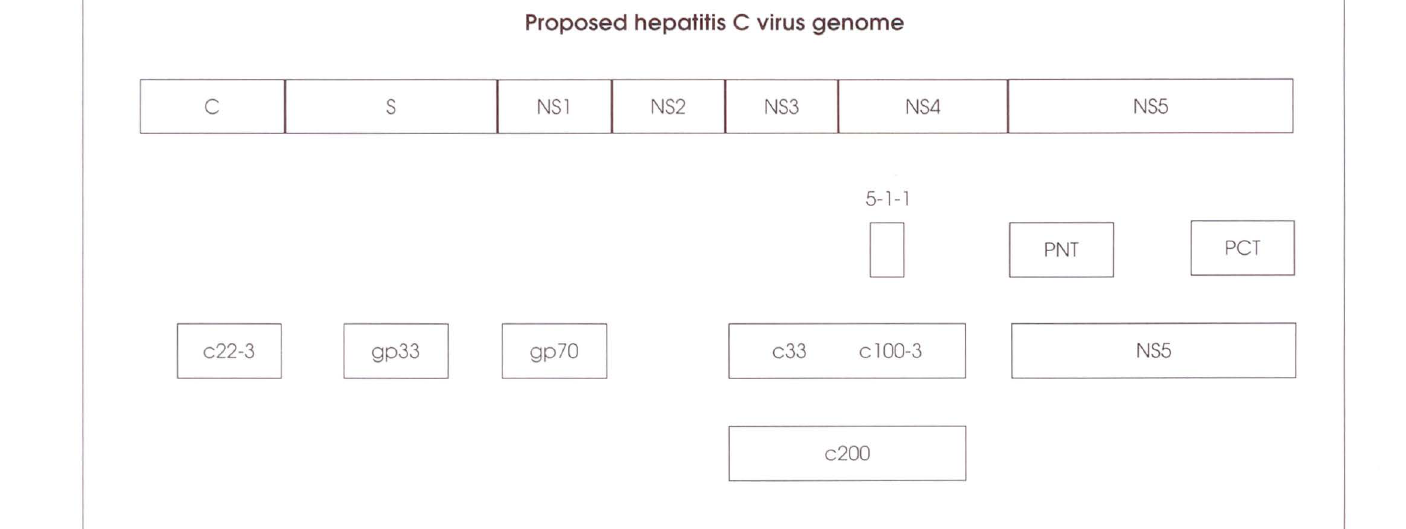
Figure 1) The entire genome is about 10.000 bases. coding for about 3000 amino acids. Only the translated portions of the genome are shown. Not shown is a 5' conserved noncoding region of approximately 300 bases. which is located to the left of core (c) region. and a 3' noncoding region of about 50 bases. which is at the end of NS5 region. gp Glycoprotein: PCT Polymerase carboxy terminus: PNT Polymerase amino terminus. Modified from reference 8